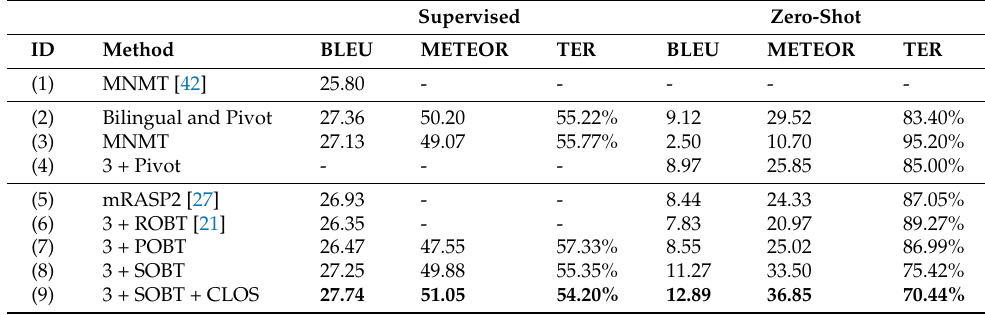
Table 3. Performance on the IWSLT-8 dataset. “Supervised” means English-centric language direc- tions seen during training. “Zero-shot” means all other 56 non-English directions unseen during training. “Bilingual and Pivot” means separately trained bilingual models for supervised directions and pivot translation based on bilingual models for zero-shot directions. The best results, indicated in bold, are statistically significant against all other results, for p <